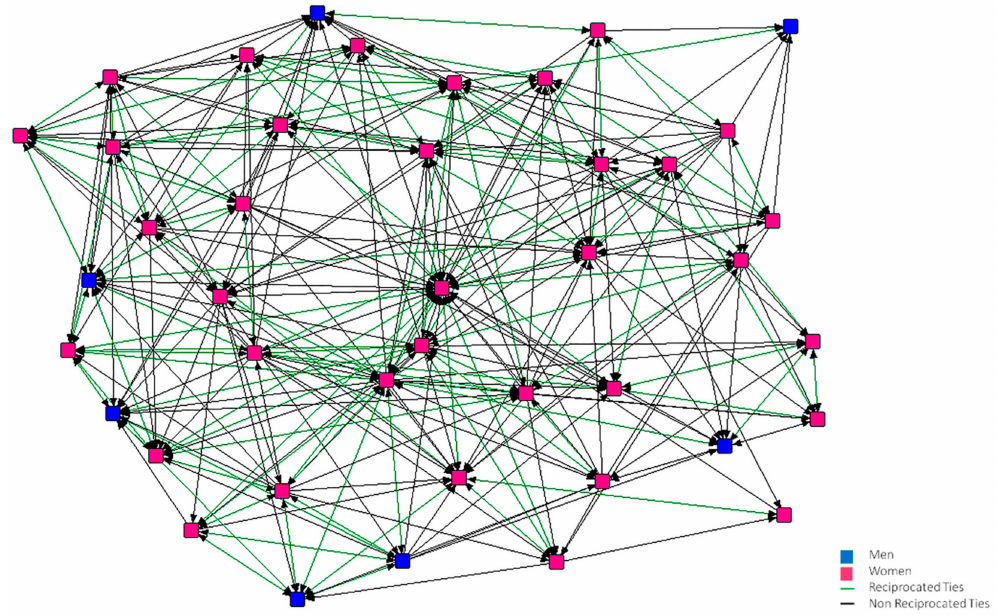
Figure 2. Graph of the third year Support